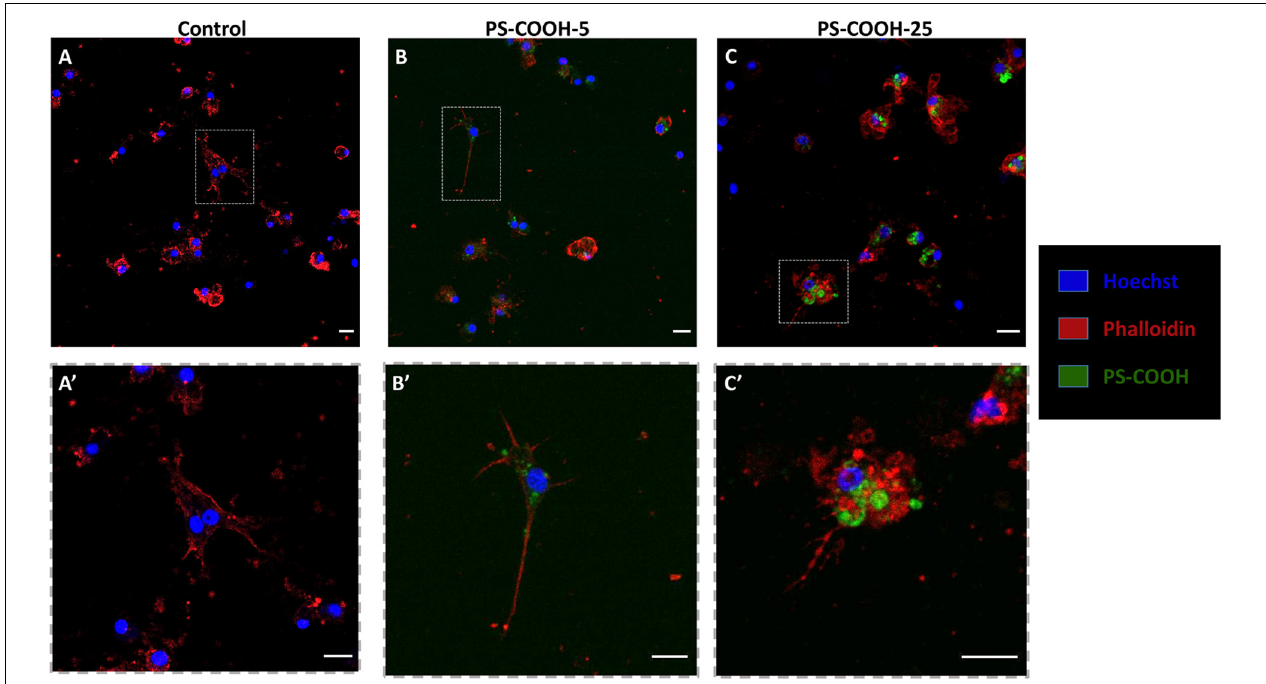
FIGURE 6 | PS-COOH disposition in sea urchin phagocytes by confocal microscopy. (A) Control phagocytes (exposed to CF only). (B,C) Internalization of fluorescent labeled PS-COOH (5 and 25 µ g mL − 1 ) in phagocytes of sea urchin P. lividus upon 4 h of exposure (blue: nuclei, red: actin and green: PS-COOH). (A’,B’,C’) Higher magnifications of the areas in the upper images are reported in the images at the bottom. Images were recorded with the same gain using a confocal microscope (Leica TCS SP8X). Scale bar: 10 µ m.